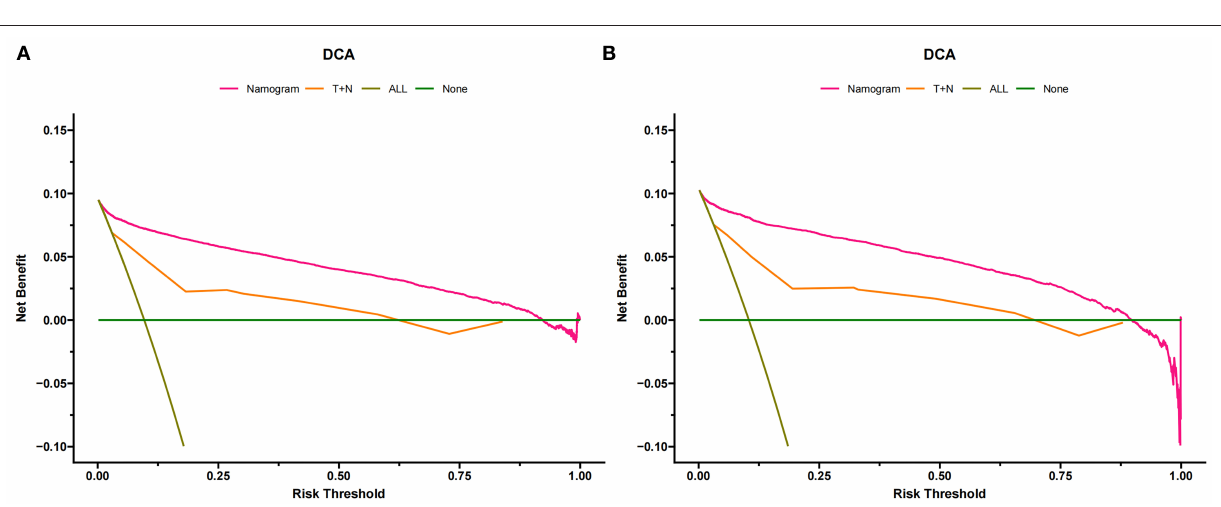
FIGURE 5 | (A) Decision curves of the nomogram predicting distant metastasis in the training cohort and (B) the validation cohort. The x-axis is the risk threshold, and the y-axis is the net benefit. The purple line indicates no distant metastasis of the patient, and the blue line shows that all patients have metastasis. When the threshold probability is between 0 and 100%, the net benefit of the model is the